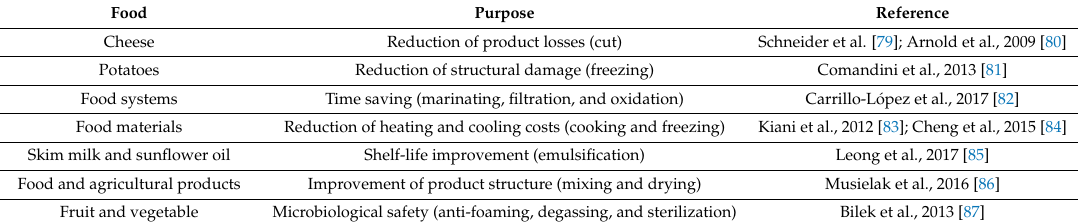
Table 2. Some applications of US that are of considerable interest in the food